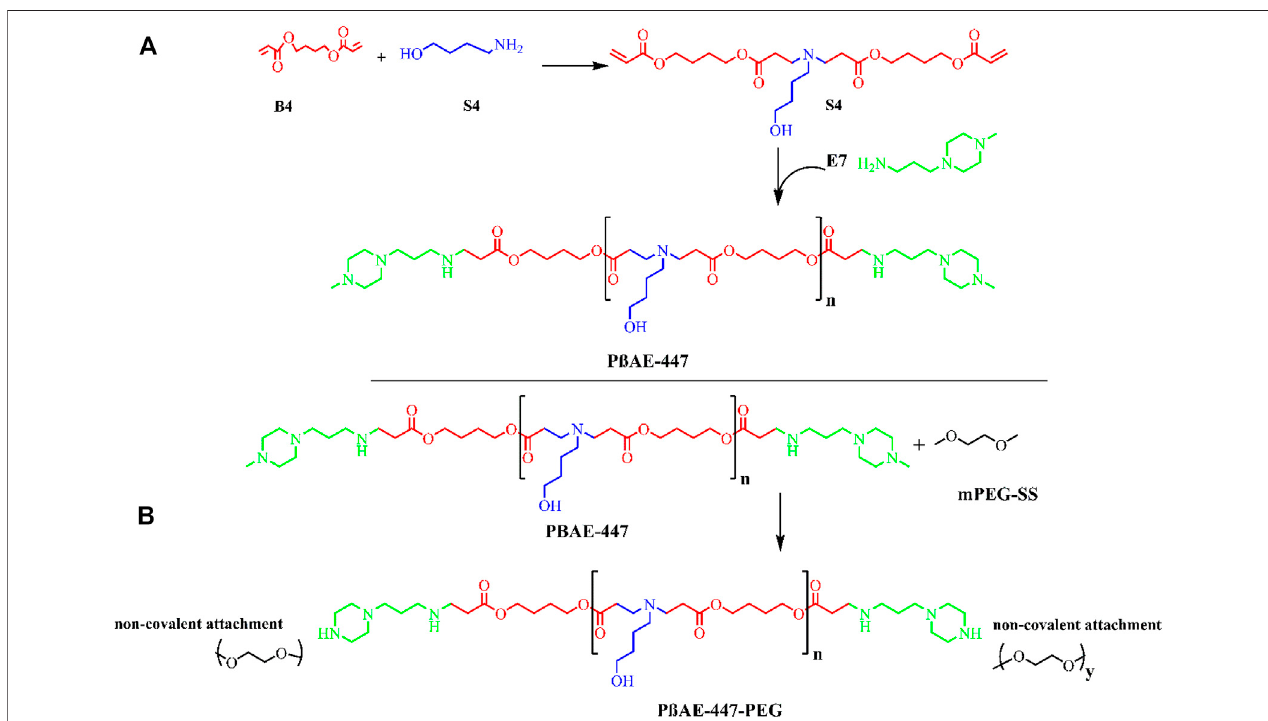
FIGURE 1 | Schematic synthesis reaction mechanism: (A) poly ( β -amino ester)-447 (P β AE-447) synthesis (B) P β AE-447-PEG.